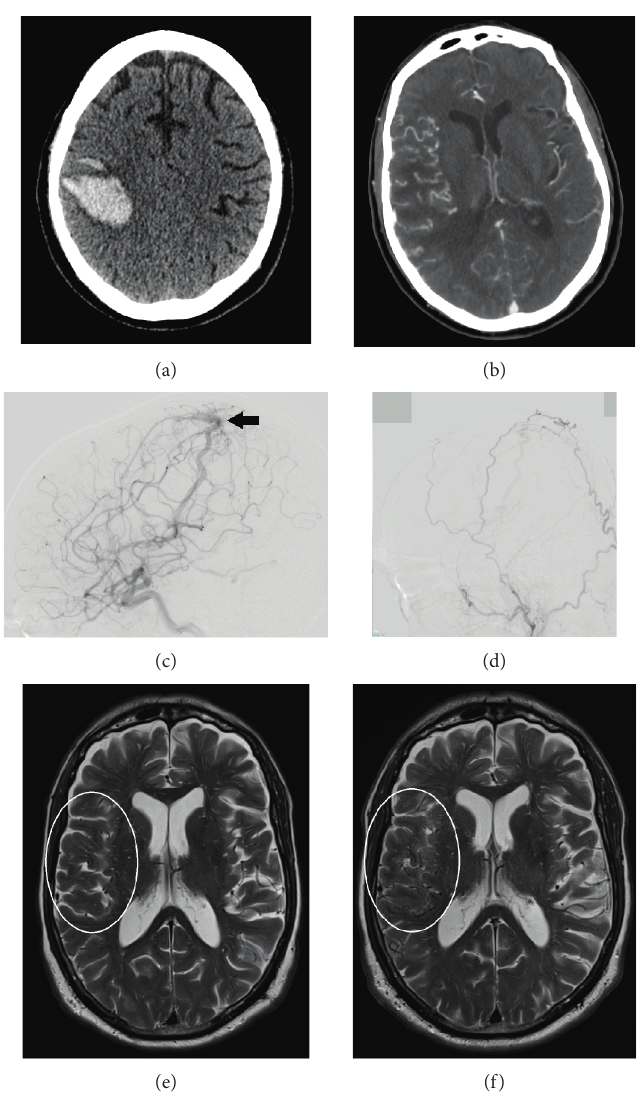
Figure 2: During readmission five months after the initial referral, consecutive CT scans showed multiple right-sided cerebral hae- morrhages, the largest being located precentrally in the frontal lobe ((a), para-axial nonenhanced). CTangiography examination ((b), para- axial MPR) showed multiple tortuous, engorged pial veins of the right hemisphere. Cerebral angiography confirmed the presence of a suspected superficial dural arteriovenous fistula ((c), lateral projection of right internal carotid artery injection, large black arrow) in the right parietal region. The arterial feeders were mainly meningeal branches originating from the right ophthalmic artery and transosseous feeders from the right superficial temporal and occipital arteries ((d), lateral projection right external carotid artery injection); in addition, there was limited arterial supply to the fistula from the left middle meningeal artery, across the midline (not shown). Venous drainage was through a large, right temporal draining vein (large white arrow), with reflux into multiple tortuous, superficial frontotemporal veins, as shown in Figure 2(b), indicating a fistula with a high risk of haemorrhage. Comparison of axial T2-weighted images of MRI examinations at initial admittance (e) and at the second admission (f) showed the new finding of dilated pial veins (encircled), demonstrating the de novo development of the dural AV